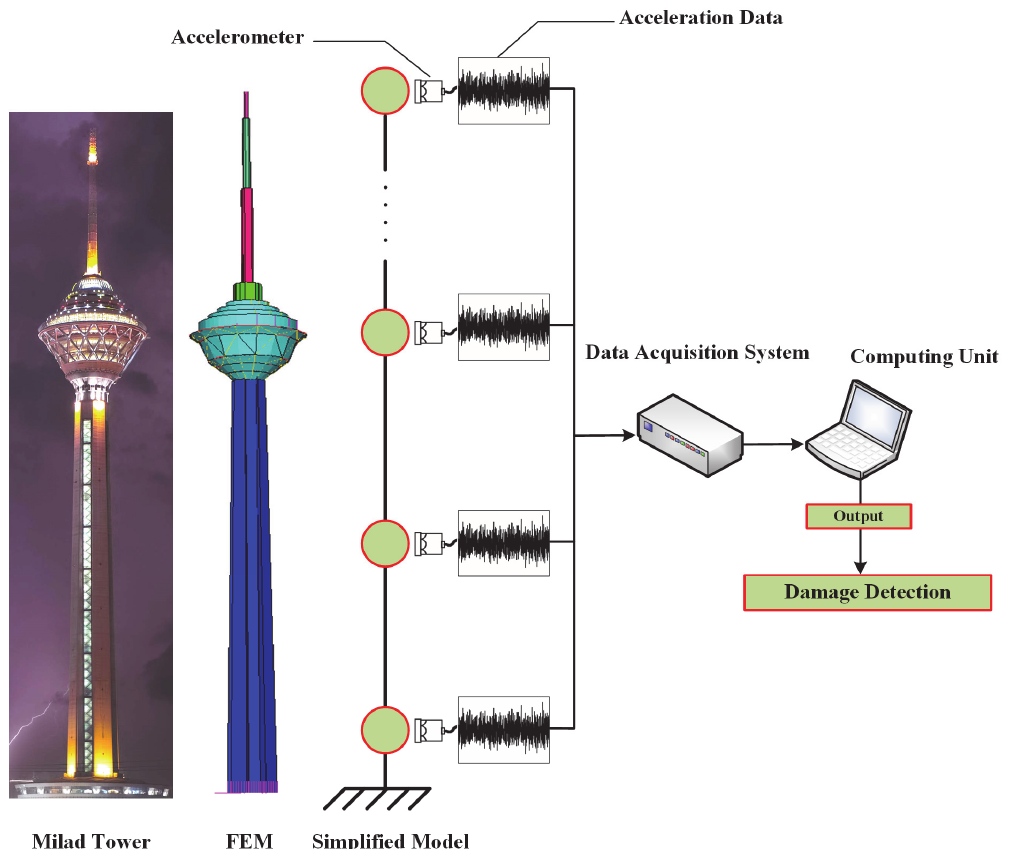
Figure 1: The schematic of vibration-based damage detection procedures (3D model courtesy of Faham Tahmasebinia).